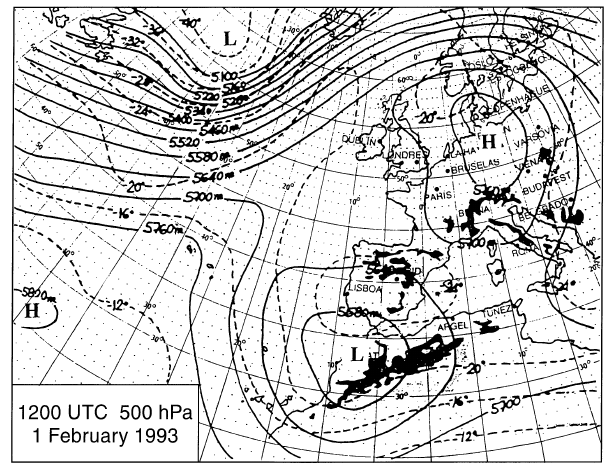
Fig. 6a–f. Isohyets of daily rain- fall (mm) over Segura Basin for a 30 January; b 31 January; c 1 February; d 2 February; e 3 February and f 4 February 1993. The study domain was mapped at a scale of 1:850000. Location of Murcia station is shown by tri- angle